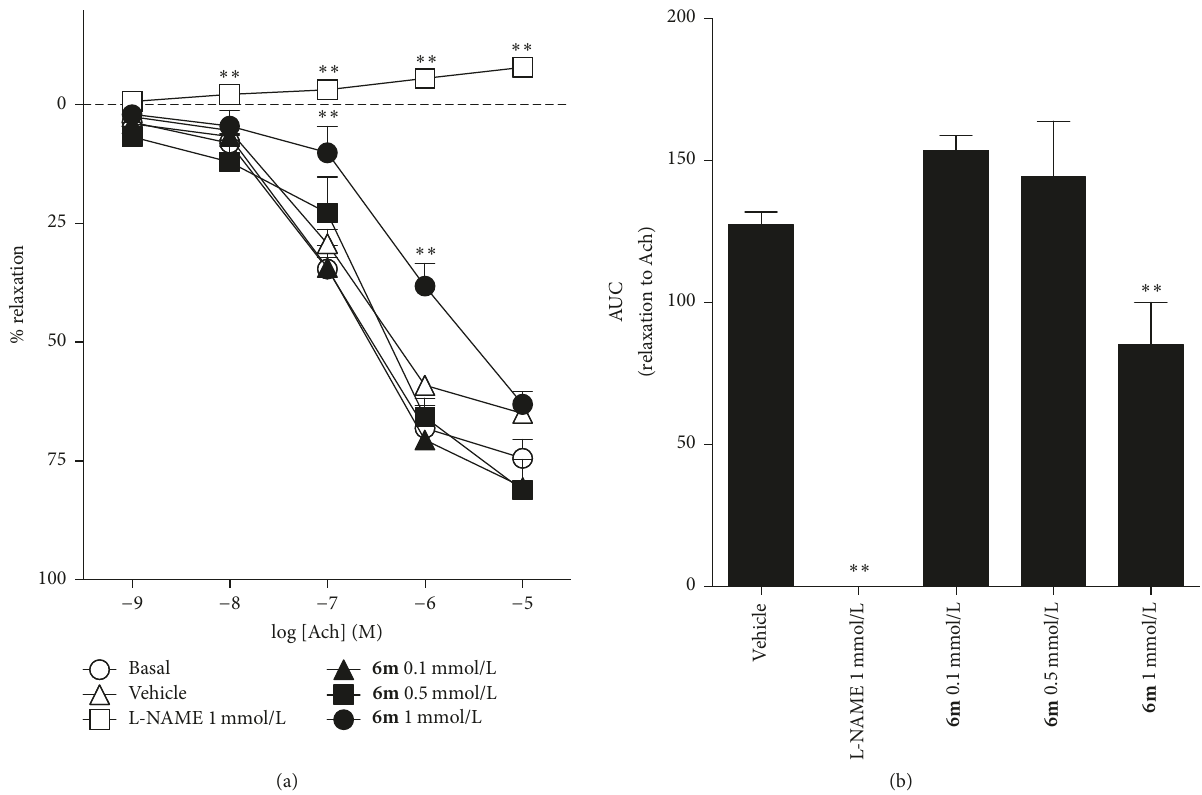
Figure 4: Effects of 6m on eNOS activity. (a) Acetylcholine- (Ach-) evoked relaxation in aortic rings with endothelium contracted with 1 𝜇 mol/L phenylephrine under basal conditions and after incubation with DMSO, 6m (0.1, 0.5, 1mmol/L), or L-NAME (1mmol/L) for 30 min ( 𝑛 = 5 ). (b) Area under relaxant-response curve (AUC) to Ach from experiments to (a). Data are expressed as the mean ± SEM of 𝑛 experiments. ∗∗ 𝑃 < 0.01 versus vehicle